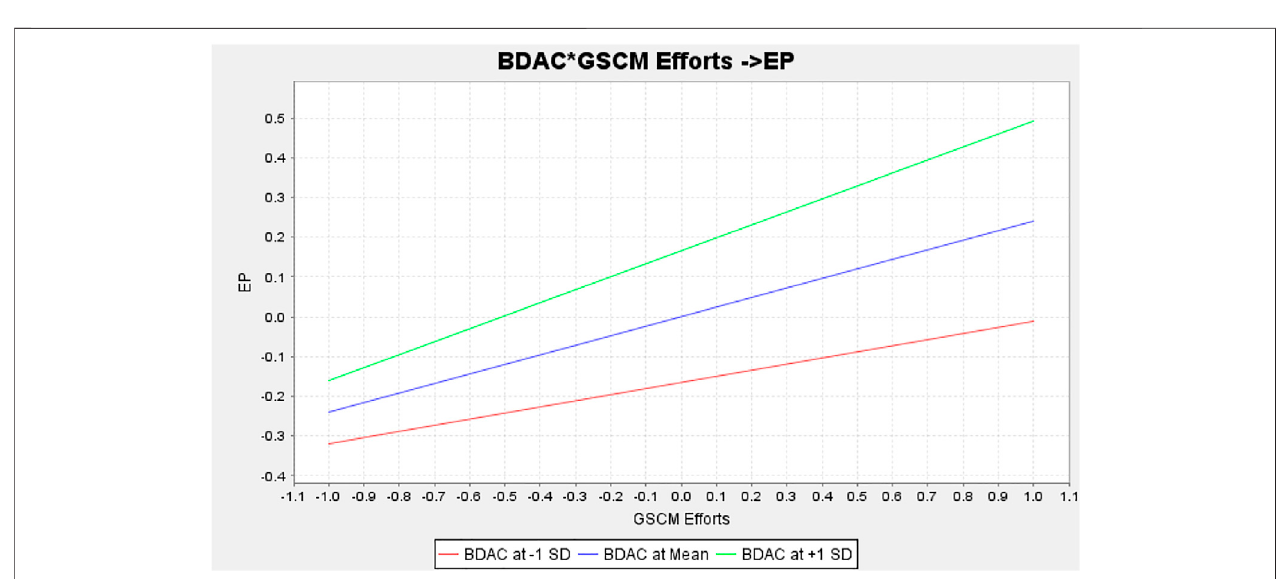
FIGURE 4 | Moderating of BDAC on GSCM efforts and